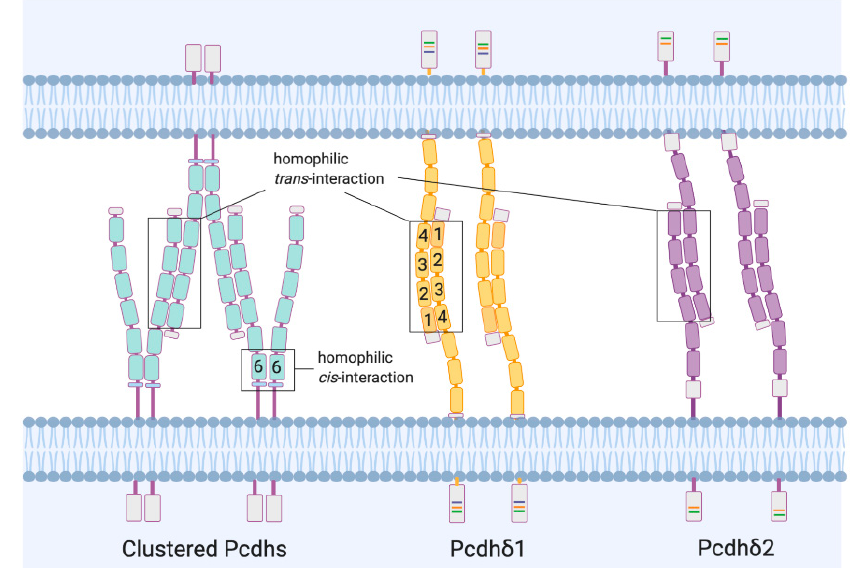
Figure 4. PCDH-mediated cell interaction. Clustered and Non-clustered PCDH isoforms, from di ff erent neurites of two cells, recognize each other in an anti-parallel fashion through strict homophilic trans -interactions of the EC1-EC4 domains, to mediate the adhesion between cells. In Clustered PCDH isoforms it is also possible to observe promiscuous cis -interactions between EC6